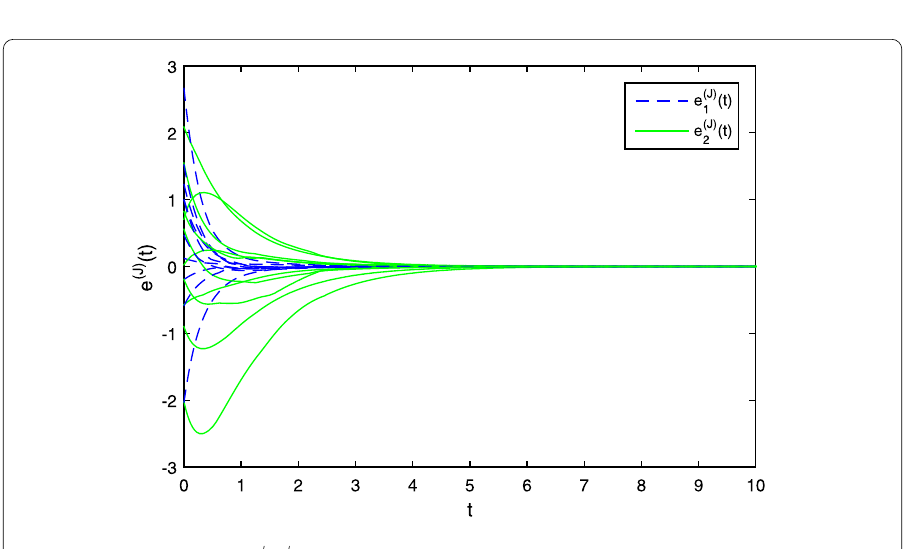
Figure 3 The error curves of e J 1 , e J